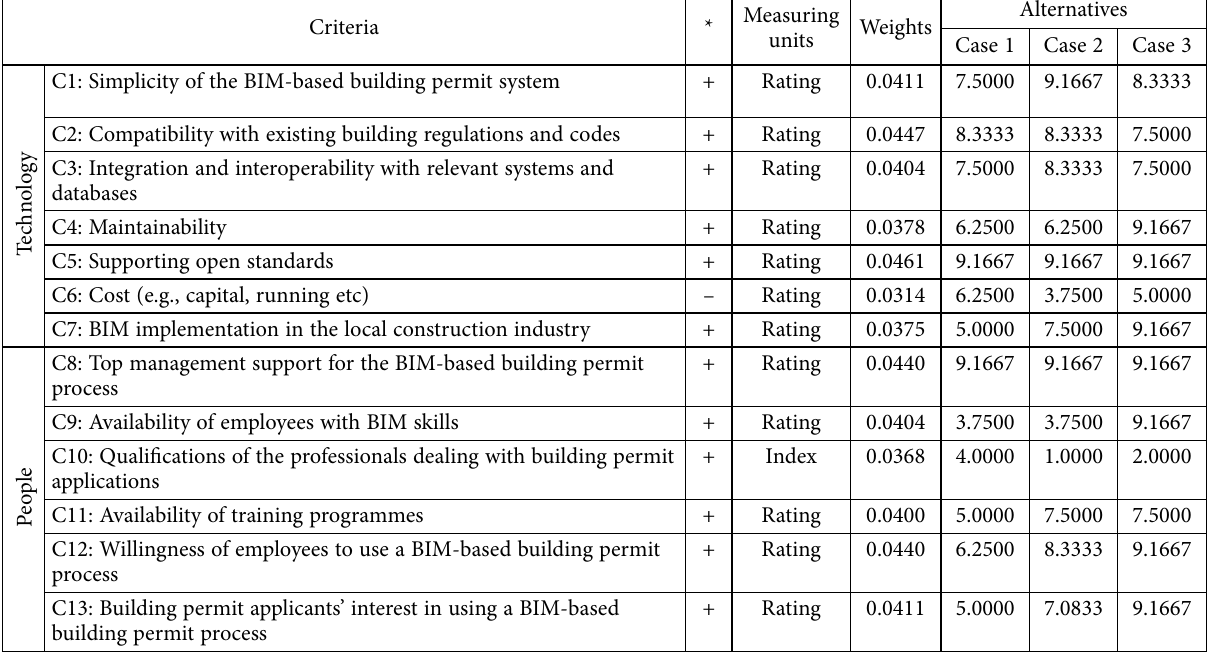
Table 7. Initial data for readiness